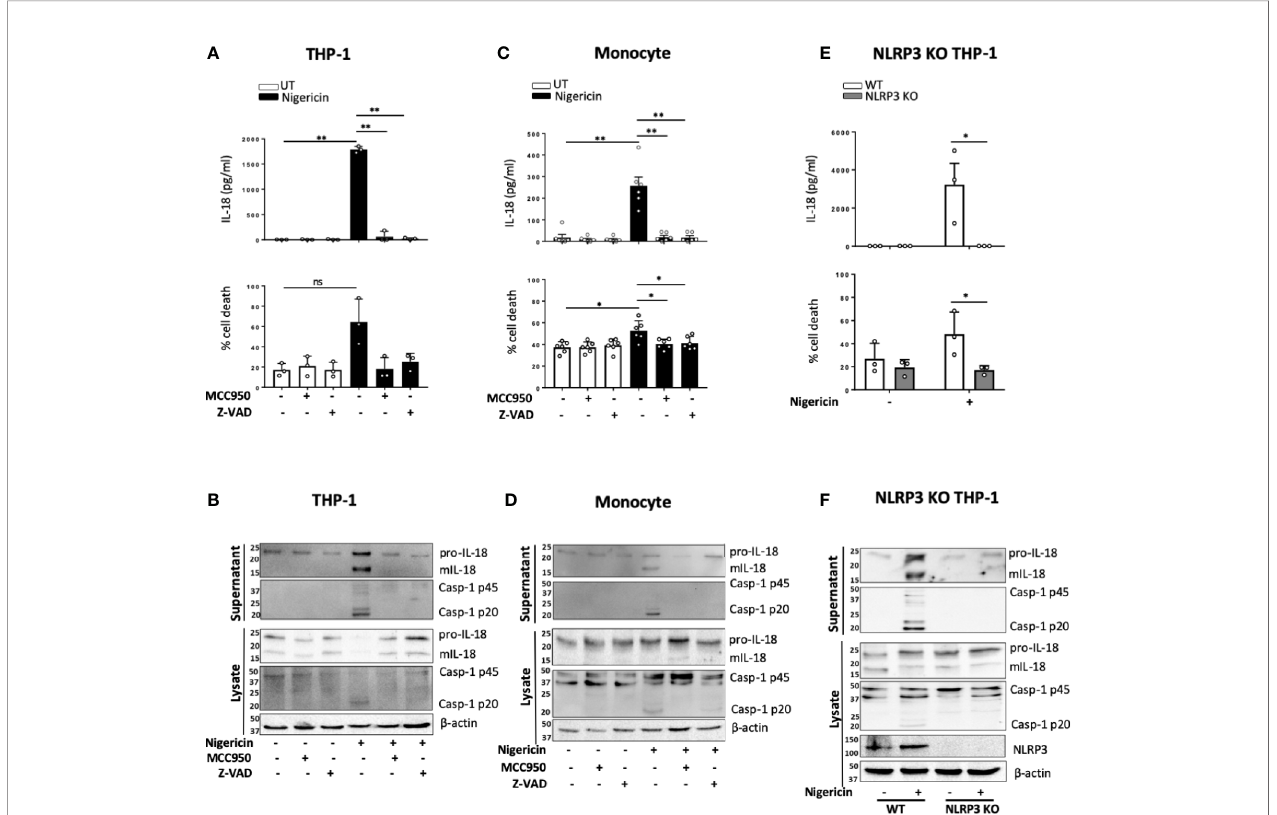
FIGURE 3 | mIL-18 release in the absence of priming is NLRP3 dependent. THP-1 cells (A, B) and monocytes (C, D) were pre-incubated with MCC950 (1 µM) or Z-VAD (50 µM) for 15 min prior to treatment with nigericin (10 µM, 45 min). (A, C) Secreted IL-18 was measured by ELISA and cell death was measured by LDH assay and shown as percentage relative to total cell death, n=3 independent biological replicates for THP-1 and n=6 independent blood donors for human monocytes, mean ± S.D., *P < 0.05; **P < 0.01; ns (not signi fi cant) using one-way ANOVA comparing each sample to the nigericin only treated sample. (E, F) Unprimed WT or NLRP3 KO THP-1 were treated with nigericin (10 µM, 45 min). (E) Secreted IL-18 was measured by ELISA and cell death was measured by LDH assay and shown as percentage relative to total cell death, n=3 independent biological replicates, mean ± S.D., * = P < 0.05; ns (not signi fi cant) using two-way ANOVA comparing nigericin treated WT and NLRP3 KO THP-1s. (B, D, F) Western blot analysis for mIL-18 (18 kDa), pro-IL-18 (24 kDa), mCaspase-1 (20 kDa), pro-Caspase-1 (45 kDa), and in some cases NLRP3 (113 kDa), as well as loading control b -actin (42 kDa). Blots are representative of at least 3 independent biological experiments and blood